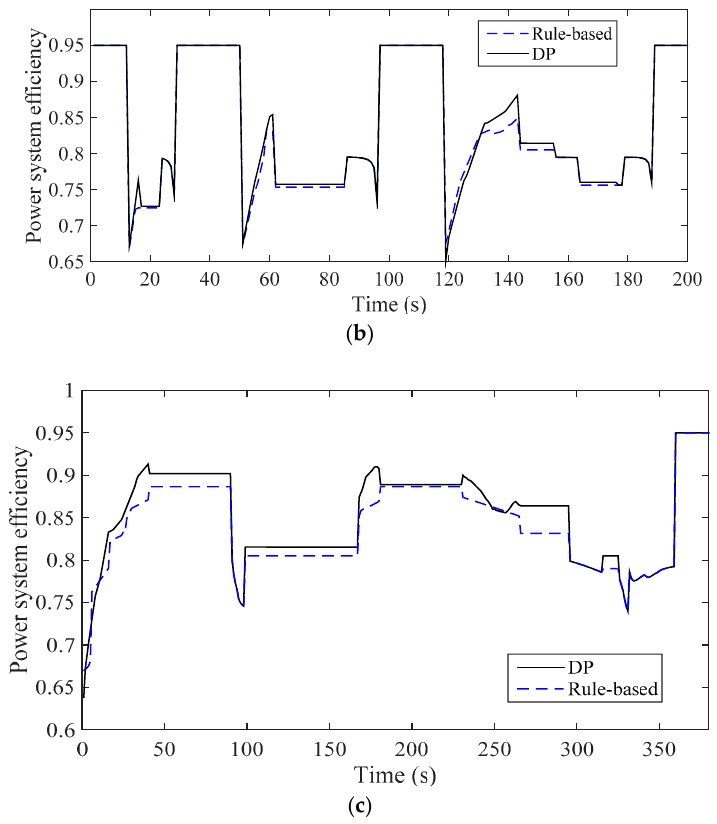
Figure 16. Power system efficiency comparison of DP and rule-based strategy. ( a ) NEDC driving cycle; ( b ) Urban driving cycle; ( c ) Suburban driving